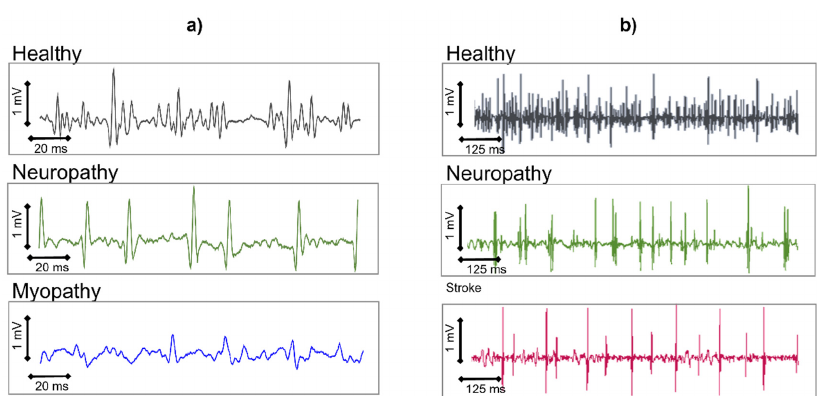
Figure 23. Characteristic changes in the normal double differential spatially filtered (Figure 16) high-density sEMG (HDsEMG) signal associated with different disorders: ( a ) myopathies lead to a change in the shape of the motor unit action potentials (MUAPs) while neuropathies lead to a decrease in the number of MUAPs contributing to the signal; ( b ) neuromuscular disorders involving the upper motor neuron, such as stroke, are characterized in the spatially filtered HDsEMG signal not only by fewer active motor units, but also by a lower variability in firing rate [49,54]. For a better representation of these effects, ( a , b ) have different temporal scales.